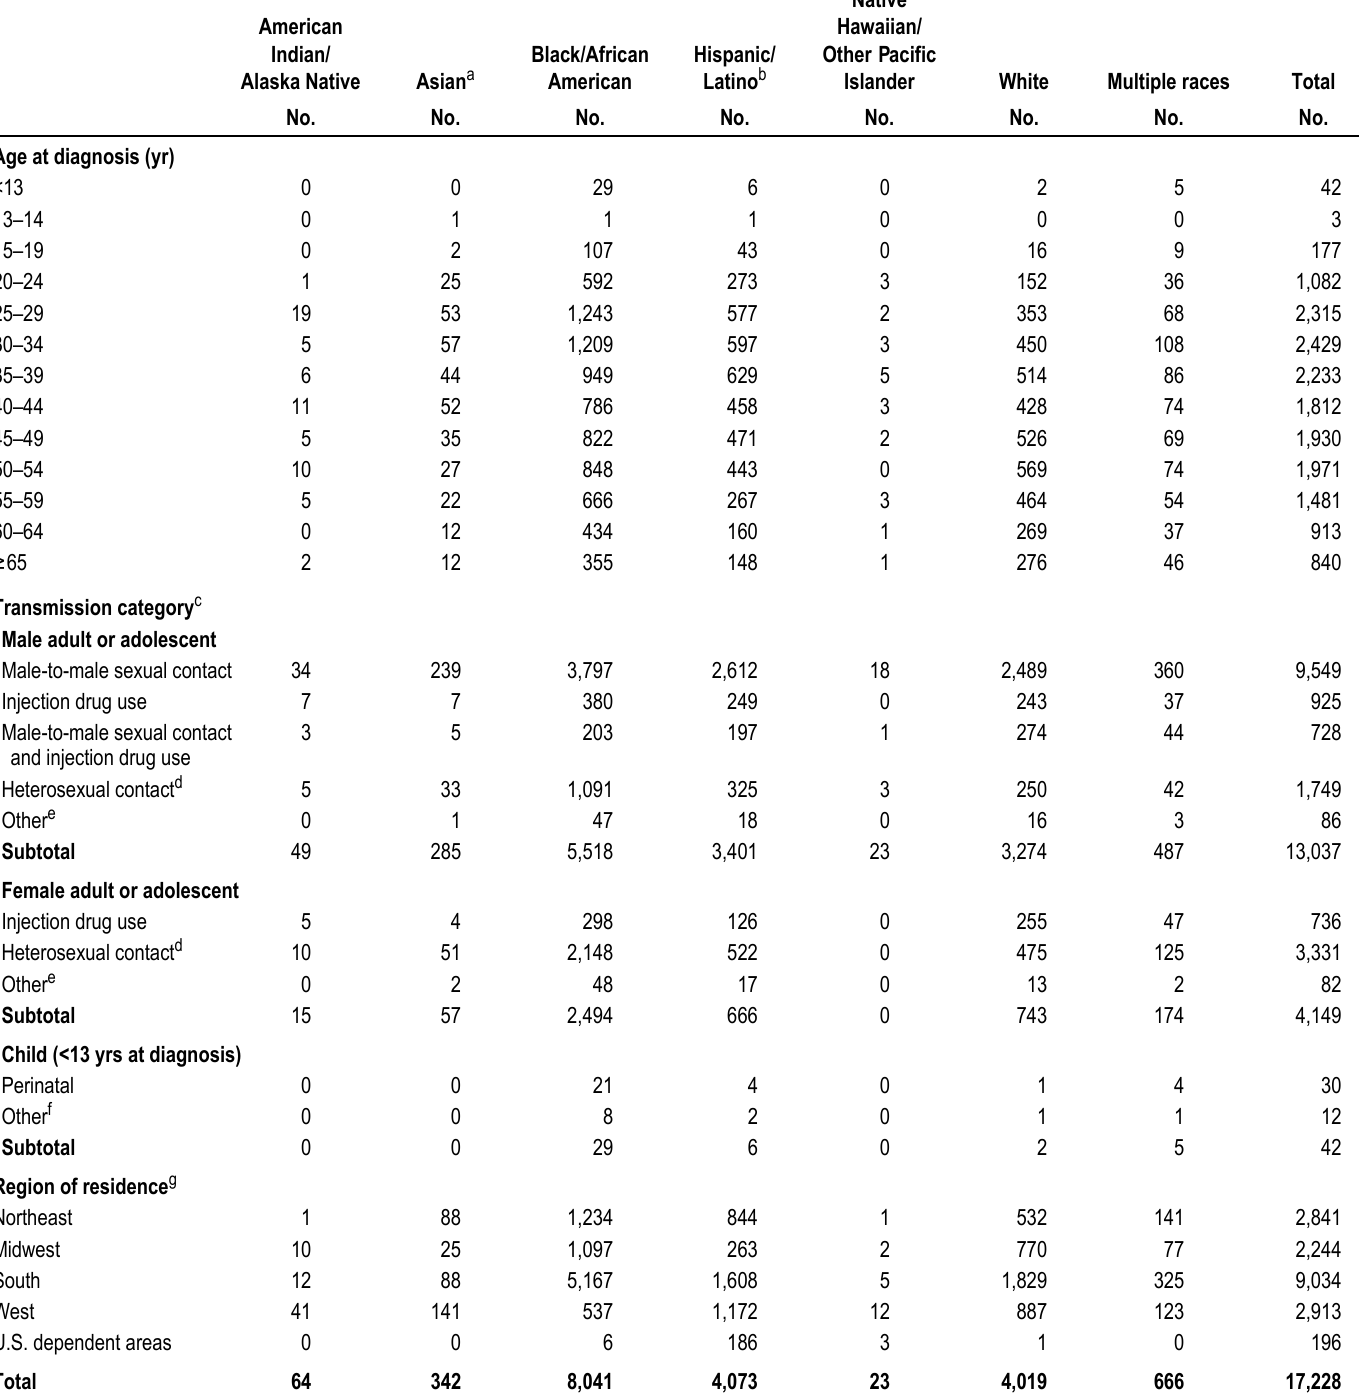
Table 4b. Stage 3 (AIDS), by race/ethnicity and selected characteristics, 2018—United States and 6 dependent